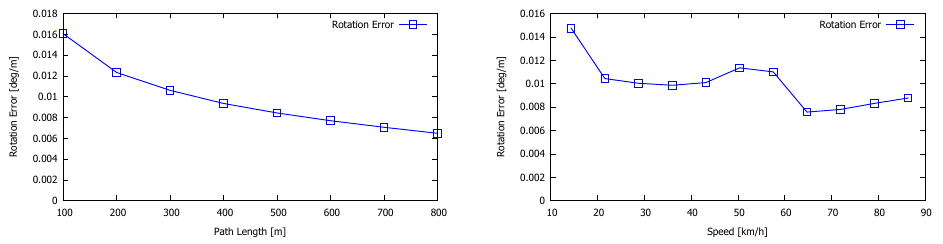
Figure 19. Results of the Kitti vision benchmark showing the average rotation error of all test sequences. Left: the rotation error is expressed as a function of the path length. Right: the rotation error is expressed as a function of the speed.